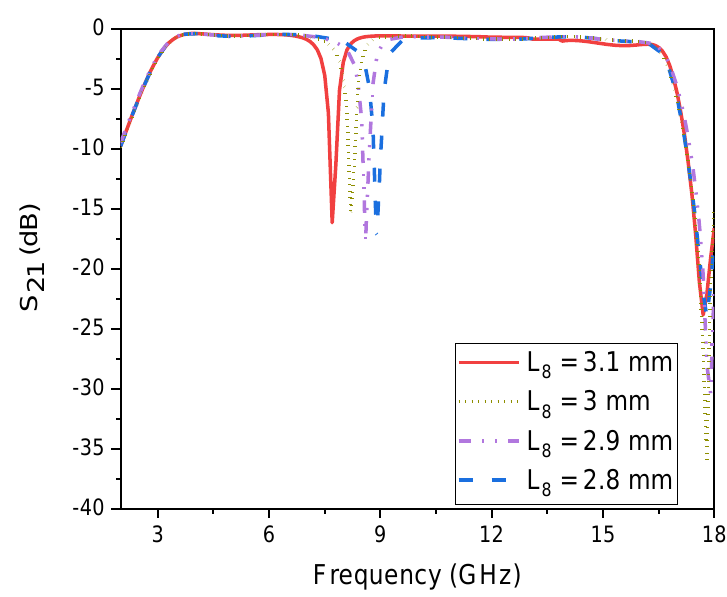
Figure 7. Response of the proposed C-shaped resonator at 8.3 GHz.